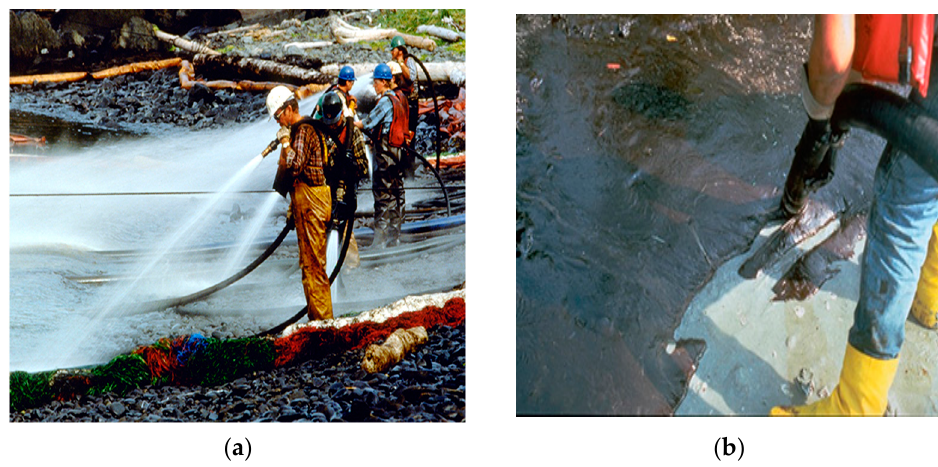
Figure 4. Cleaning oiled rocks with ( a ) high-pressure hoses after the 1989 Exxon Valdez oil spill in Prince William Sound, Alaska; ( b ) Heavy oil vacuumed from a sandy beach following the 1993 oil spill, Tampa Bay (Public domain: credit to NOAA’s Office of Response and Restoration).